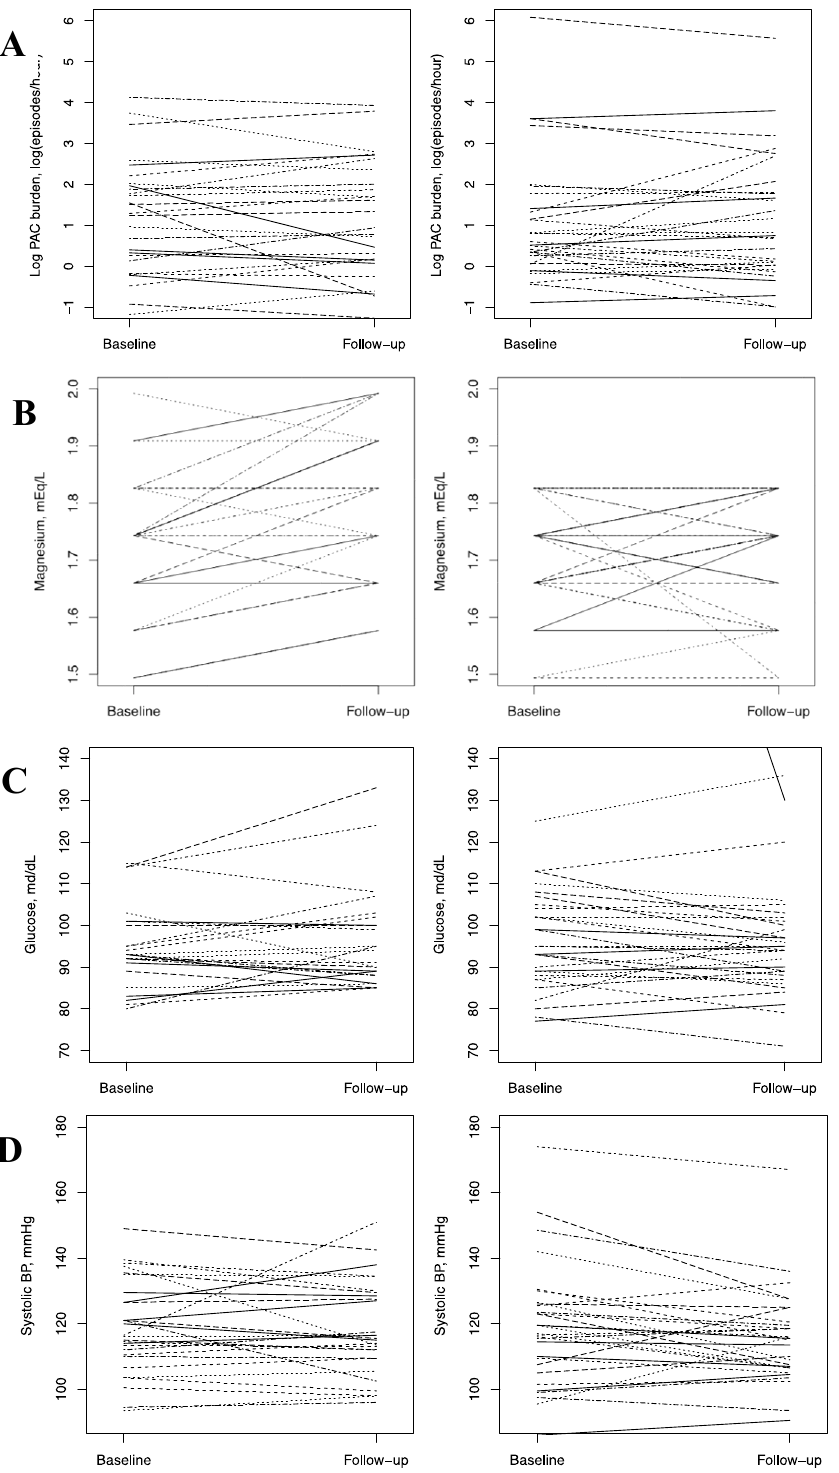
Figure 2. Spaghetti plots for change in ( A ) log PAC burden, ( B ) change in serum magnesium, ( C ) serum glucose *, and ( D ) SBP (systolic blood pressure). * One participant had a baseline glucose concentration of 307 mg/dL. The baseline value for this participant is outside the frame. PAC, premature atrial contractions; and BP, blood pressure.